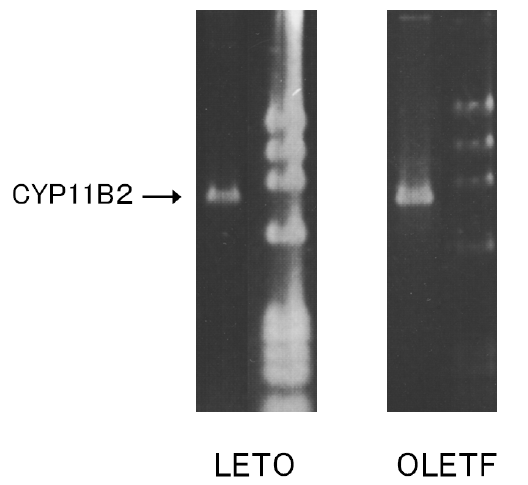
Figure 1. RT-PCR analysis of the CYP11B2 mRNA expression of AoSMC prepared from OLETF diabetic rats and control LETO rats.The mRNA of the indicated molecules was reverse-transcribed, and the resultant cDNA was amplified with RT-PCR. Ø × 174 fragments that had been digested with Hae III were added to the right lane as a molecular weight marker.